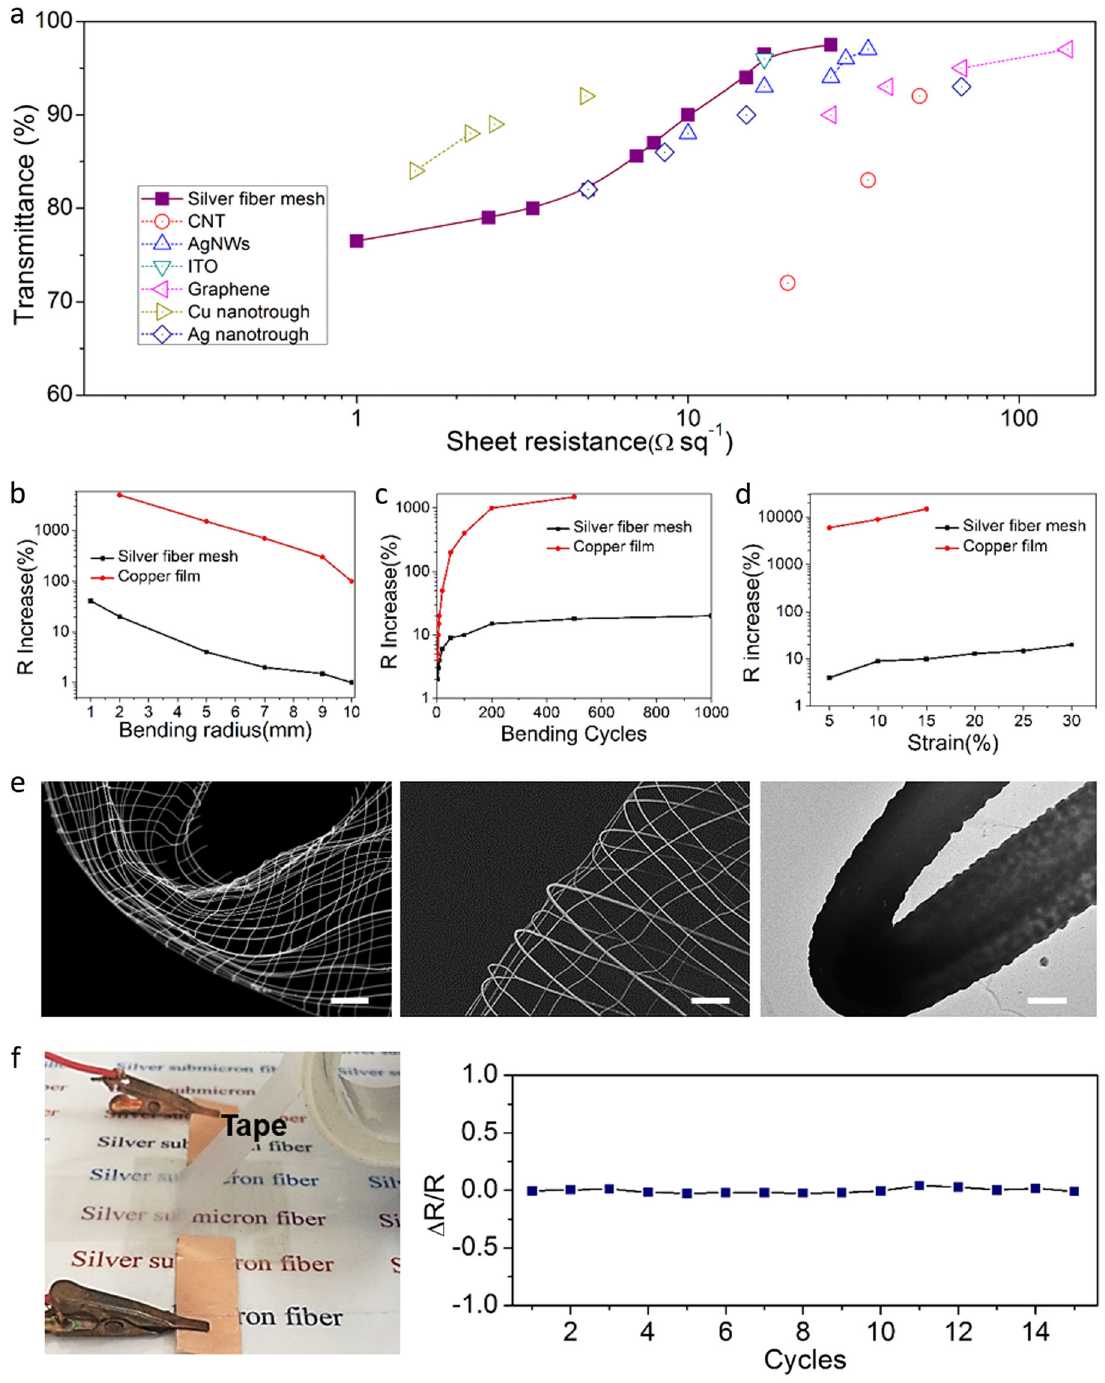
Fig. 3 Photoelectric and toughness studies of silver fi ber mesh. a Diagrammatic representation of transparency of different silver fi ber mesh as a function of the sheet resistance depicted 550 nm. b Transfer of silver submicron fi ber mesh onto a PET substrate to test their stability corresponding different bending radii (10 mm, 9 mm, 7 mm, 5 mm, 2 mm, 1 mm). c Plot between times of bending silver fi ber mesh versus the corresponding sheet resistance. (The bending radius is at 7 mm). d Change in resistance as a function of uniaxial strain for silver fi ber mesh and the copper fi lm (the silver mesh is attached to PDMS substrate of 4 mm thickness). e SEM image of the curved fi ber mesh and the TEM image of a folded fi ber (scale bar: 100 μ m, 20 μ m, 500 nm). f Stability test of sheet resistance for the silver fi ber mesh after being repeatedly fi xed with an adhesive Figure 3f depicts the results of the stability test of sheet resistance and strength of silver fi ber mesh, we seal one of the sides of the for the silver fi ber mesh sealed on the PET substrate after silver fi ber mesh on the PET substrate with a heat-sealing repeatedly attaching with the adhesive tape. The sheet resistance apparatus. The hot melt adhesive: ethylene-vinyl acetate enables essentially remained stable after repeated tape adhesion for 15 the silver fi ber mesh to be fi rmly attached on to the PET substrate.